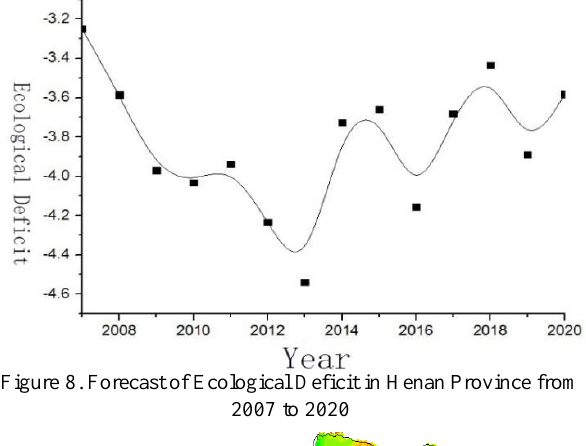
Figure 6. 2013 spatial simulation of Henan ED map